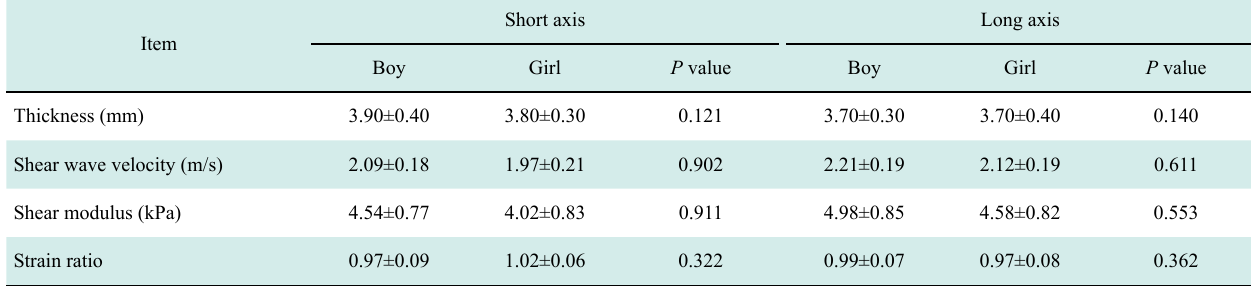
Table 2 Comparison of left and right SCM muscle thickness and elastic measurement in normal infants Item